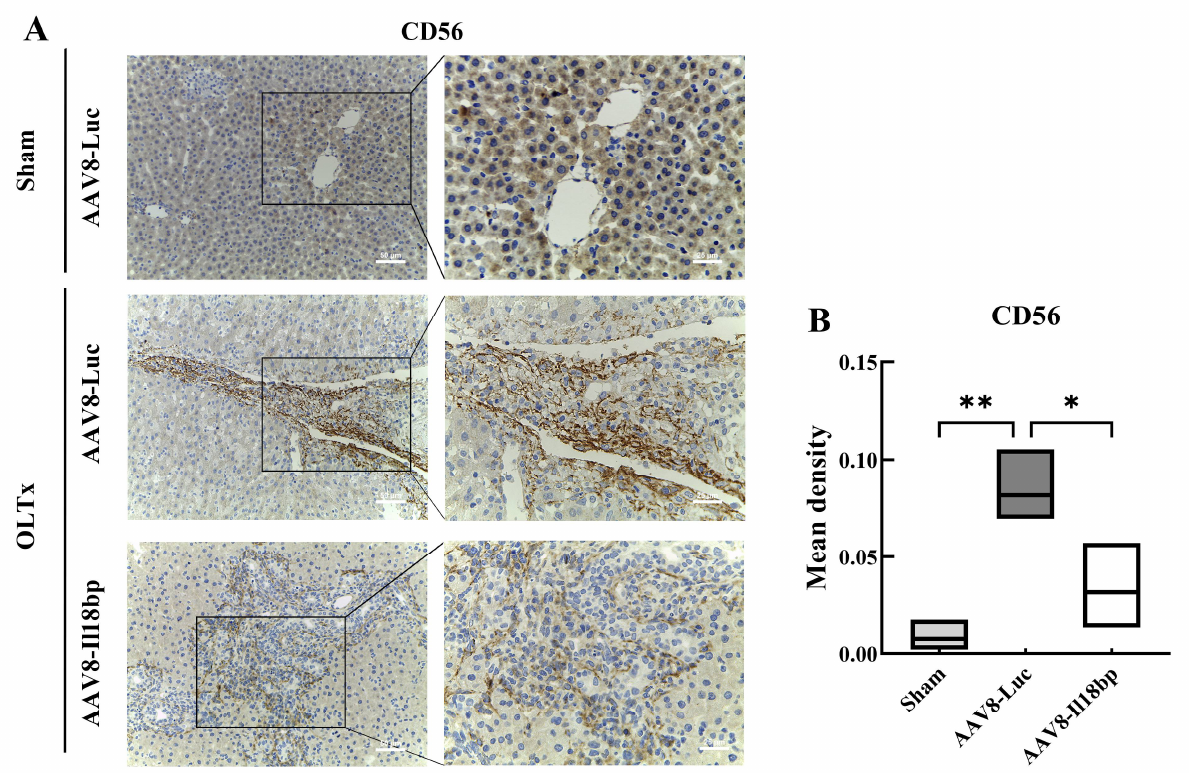
Figure 6. IL-18BP overexpression reduced CD56 expression after LEW-BN OLTx. ( A ) Representative images of IHC staining for CD56 protein in livers of different groups. Scale bar, 50 μm, 25 μm. ( B ) The cumulative frequency of tissue-infiltrating CD56 + NK cells detected by IPP 6.0 in each group; error bars represent means ± SEM ( n = 3 per group); * p < 0.05; ** p < 0.01.